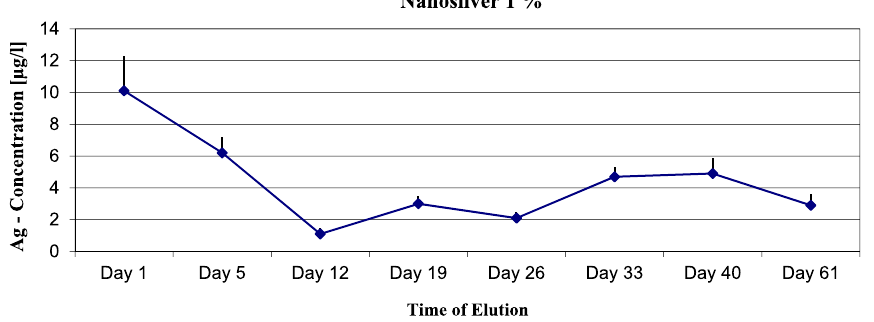
Figure 1. Nanosilver 1%—static elution model—max. Concentration of Ag-Ions 10.1